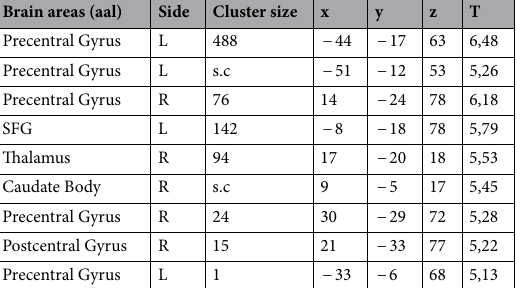
Brain areas (aal)